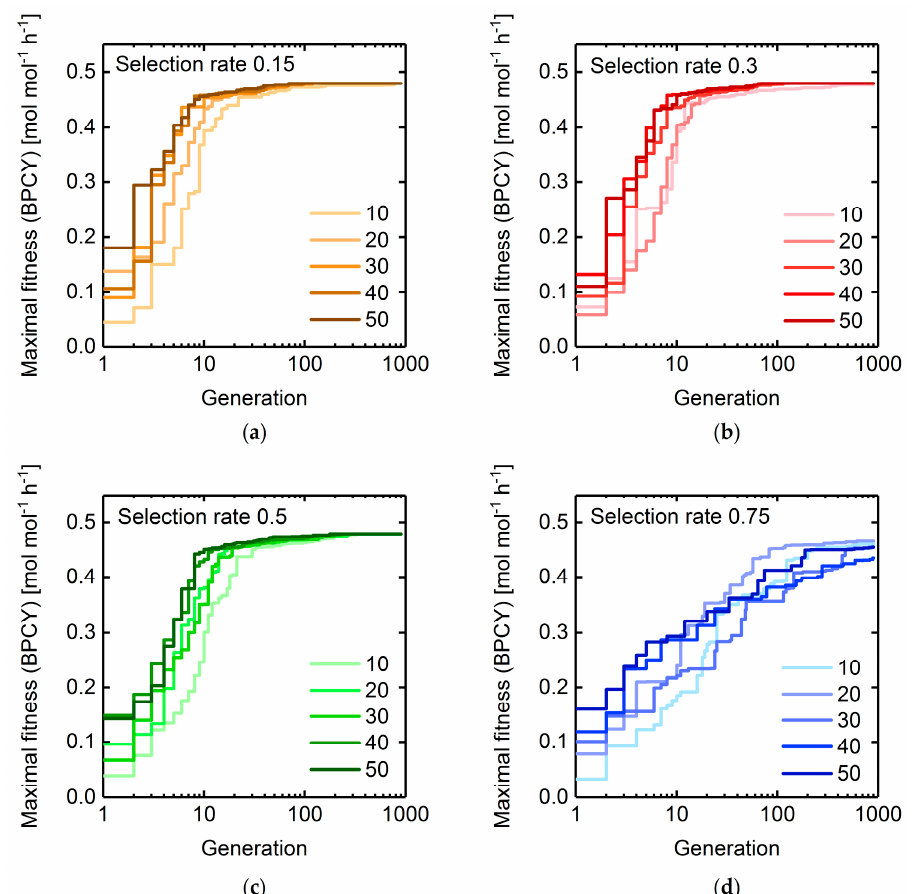
Figure 4. Maximal fitness progressions of GA runs using selection rates of ( a ) 0.15, ( b ) 0.3, ( c ) 0.5, and ( d ) 0.75. The color codes denote different population sizes ranging between 10 and 50. Generation numbers are plotted on a logarithmic scale. Deletion of maximally seven reactions were allowed. Succinate BPCY was used as the engineering objective.